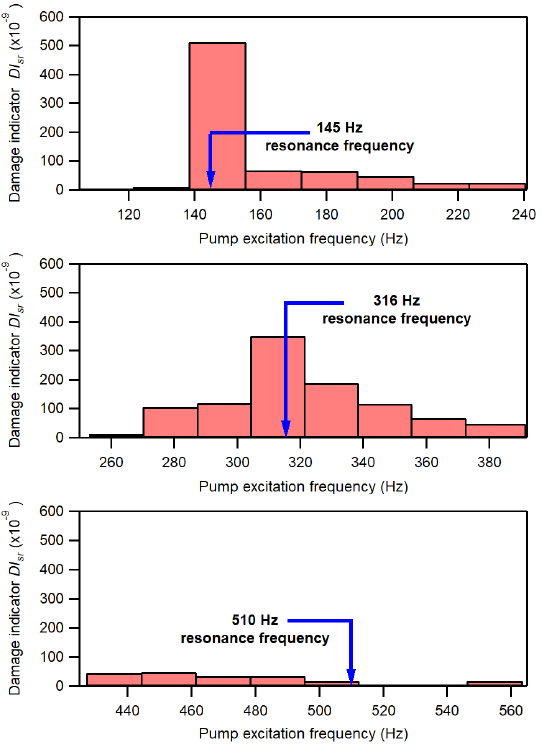
across different sub-ranges of pump excitation 𝐷𝐷𝑀𝑀 𝑠𝑠𝑠𝑠